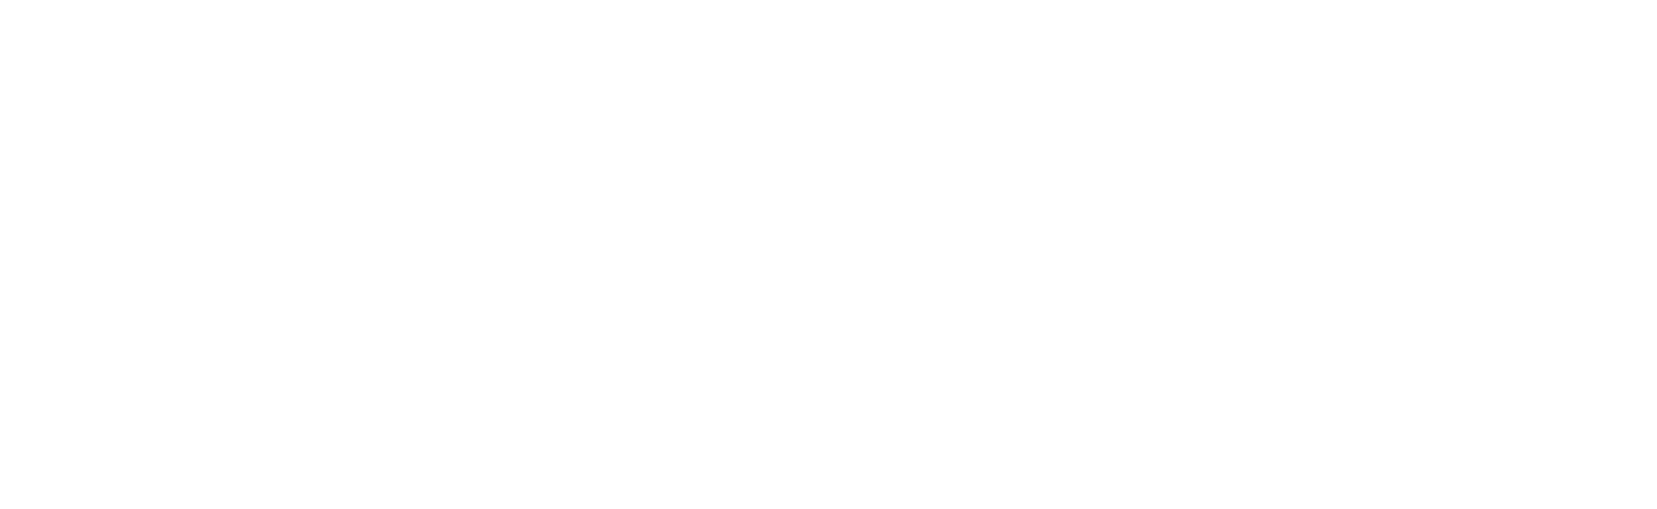
FIGURE 2 | Cumulative incidence curves of SPMs in different subgroups. (A) ALL; (B) Age; (C) Sex; (D) Race; (E) AFP; (F) Stage; (G) Tumor size; (H) Vascular invasion; (I) Grade and (J) Treatment. SPM, second primary malignancy; ALL, all patients; AFP, alpha